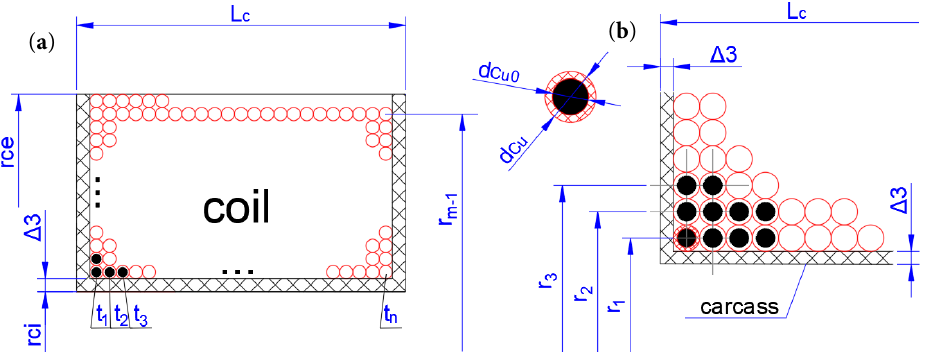
Figure 3. Dimensions of coil and conductors. Figure 3. The cross-section of clutch coil: ( a ) dimensions of coil and ( b ) dimensions of